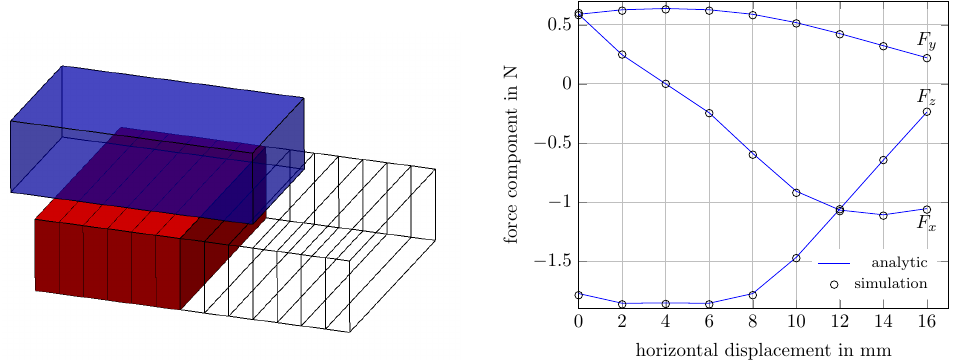
Figure 4. Two parallelepiped permanent magnets. Position of the magnets where the red is shifted through various positions in x -direction ( left ). Analytic and simulated force components ( right ).